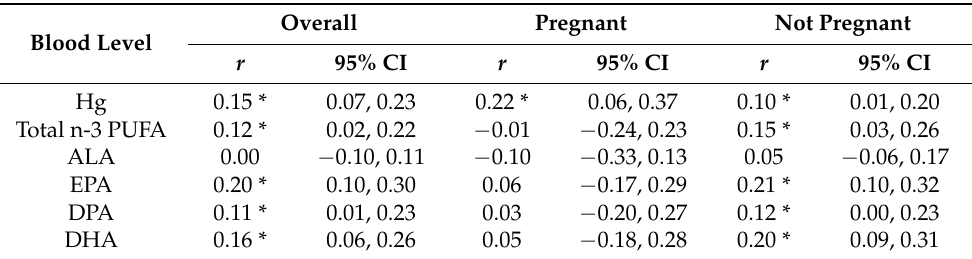
Table 3. Spearman’s correlation coefficients comparing reported seafood consumption and blood levels for Hg ( n = 549) and n-3 PUFAs ( n = 356).